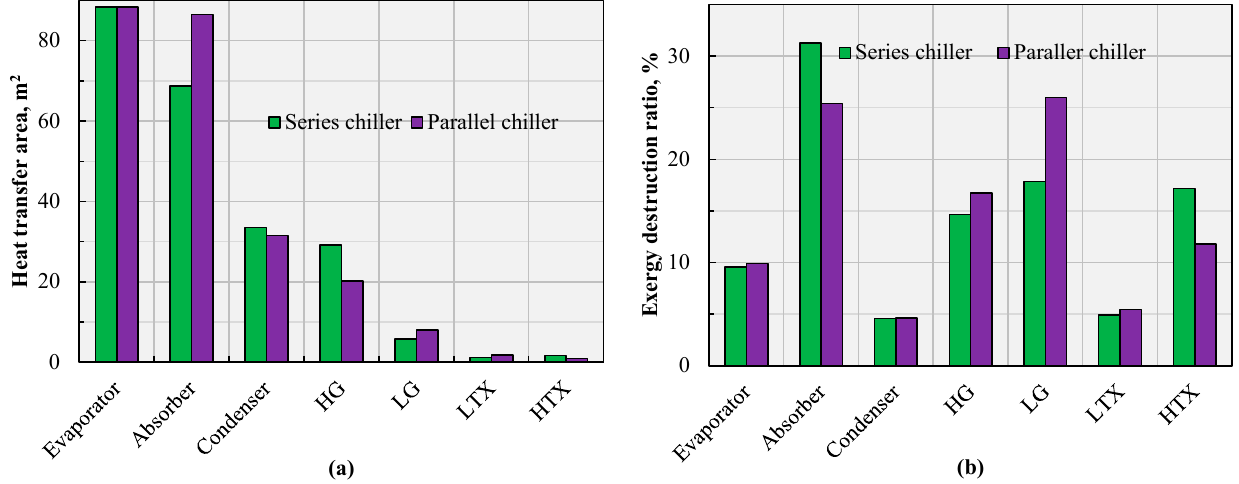
Figure 2. Heat-transfer area and exergy destruction ratio for two types of absorption chillers: ( a ) Heat-transfer area; ( b ) exergy destruction ratio.